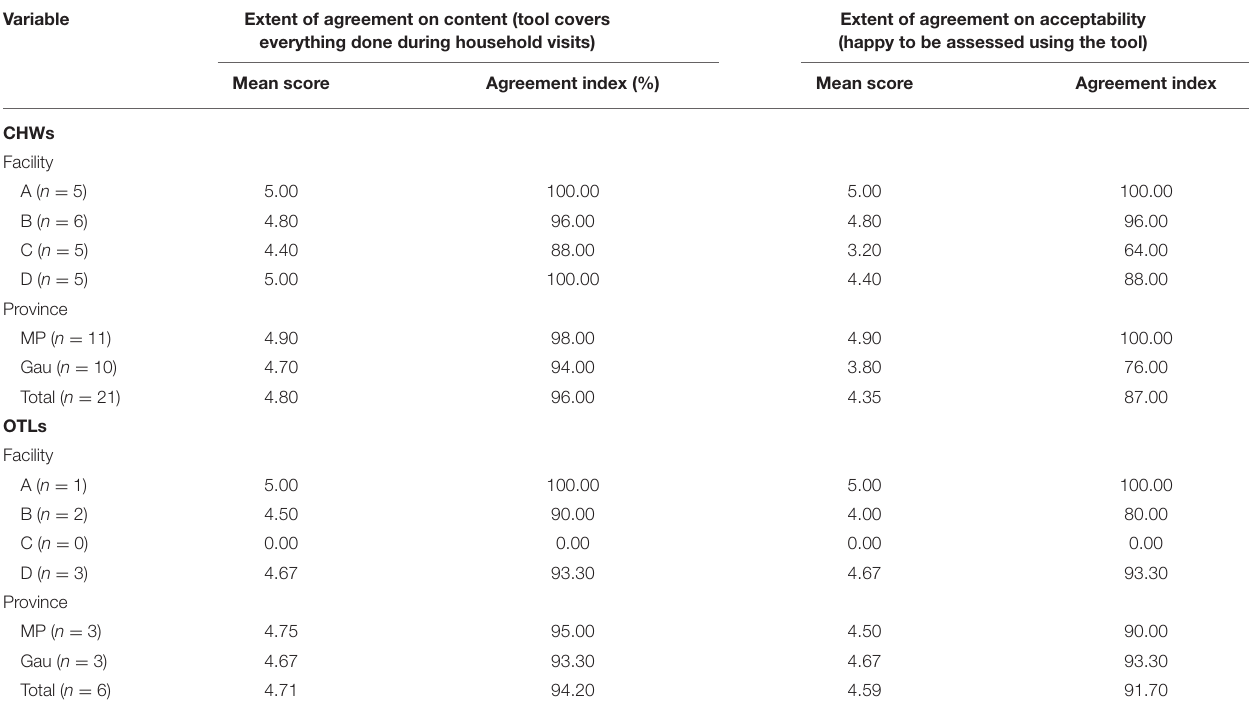
TABLE 3 | Percentage agreement of ratings by CHWs, OTLs, province and overall. Variable Extent of agreement on content (tool covers everything done during household visits)